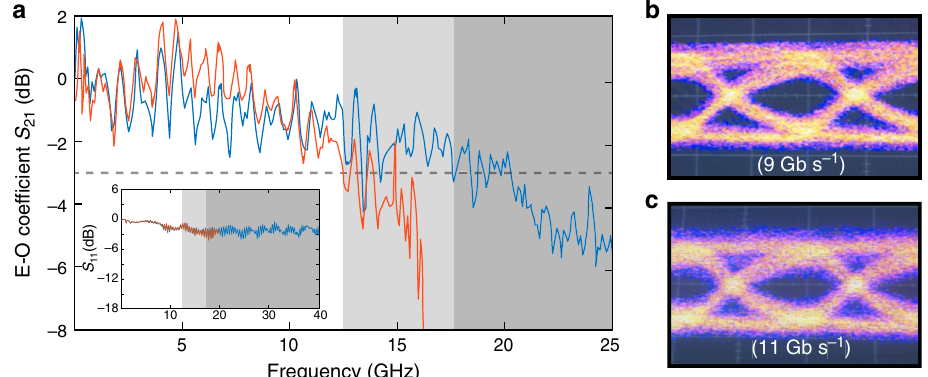
Fig. 7 High-speed electro-optic switching. a Recorded scattering parameter S 21 for two devices with optical Q of ~14,000 (blue curve) and ~20,000 (orange curve), respectively. The gray regions represents the 3-dB bandwidth limit for two devices, respectively, and the dashed line indicates the 3-dB limit of S 21 . The inset shows the S 11 re fl ection scattering parameter for both devices. b , c Eye diagrams of the photonic-crystal EOM output, measured with 2 7 − 1 NRZ PRBS with a driving voltage of V pp = 2 V. The laser wavelength was locked at half wave into the cavity